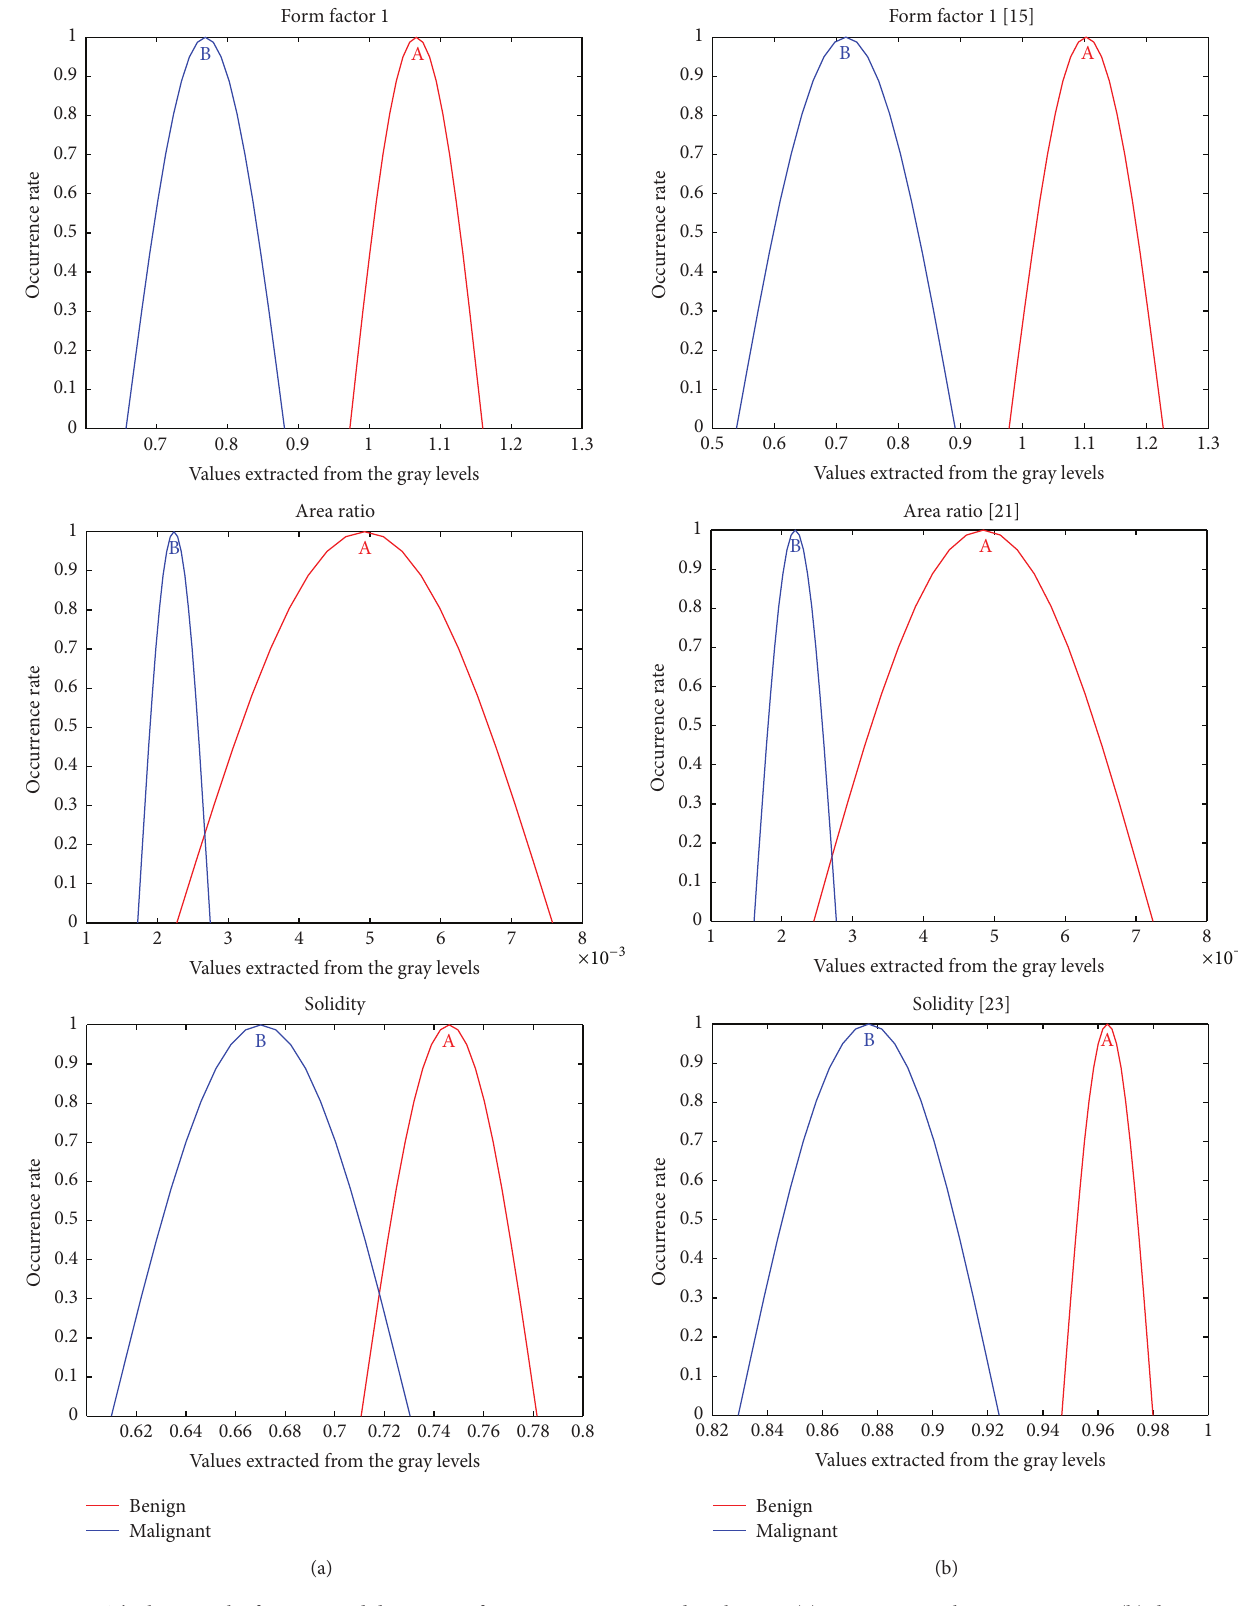
Figure 9: The best results for extracted descriptors from Gaussian curves distribution. (a) Segmentation by active contour; (b) detection by the SOM